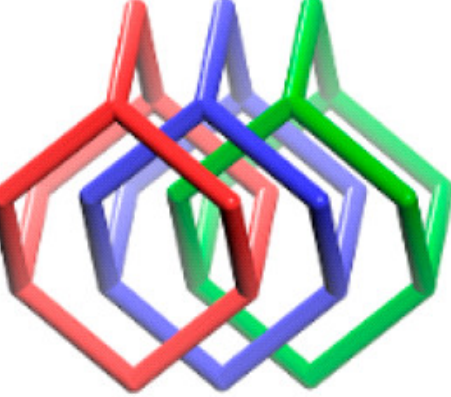
Figure 12. A 3-fold interpenetrated structure of 3D COF-anionic-DB. Reprinted (adapted) with permission from [52]. Copyright 2017 American Chemical Society.